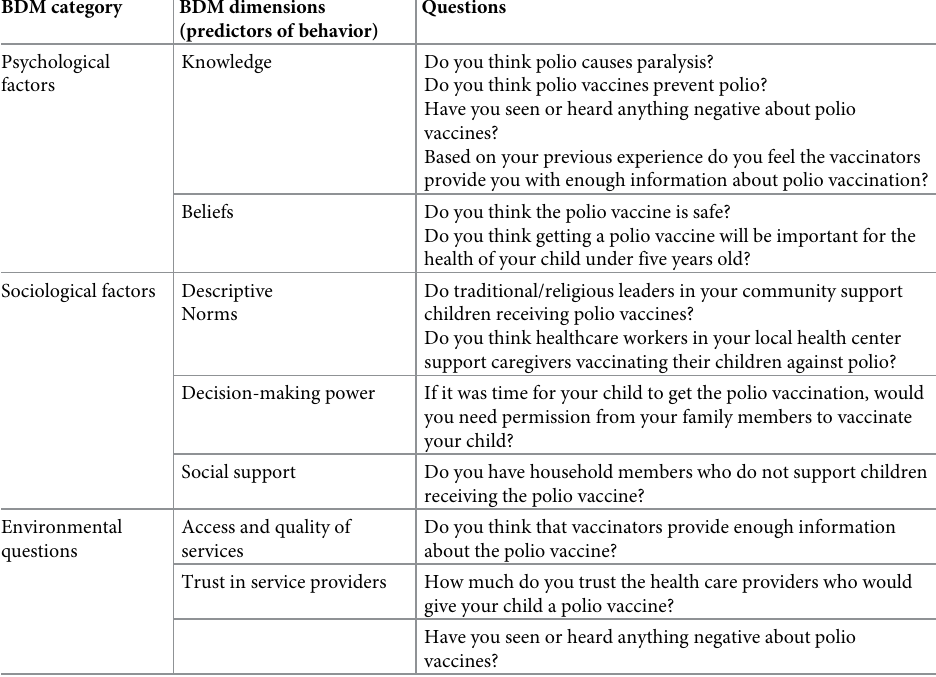
Table 1. Behavioral Drivers Model (BDM) categories, dimensions, and related questions.